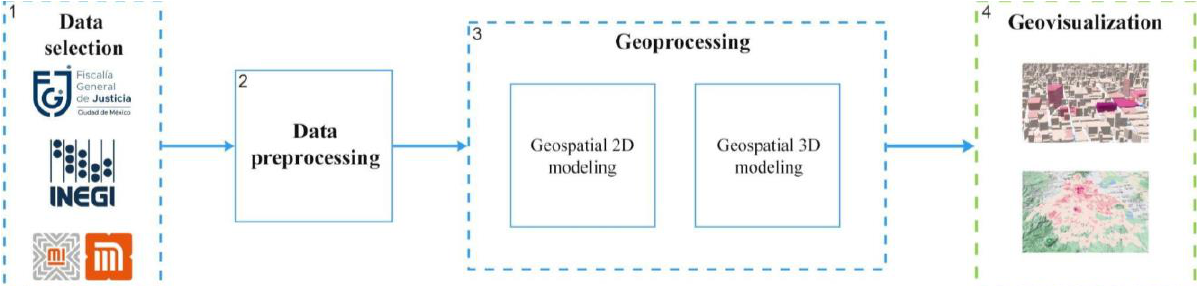
Figure 1. Proposed methodology for the analysis of different open data sources implementing map modelling to perform